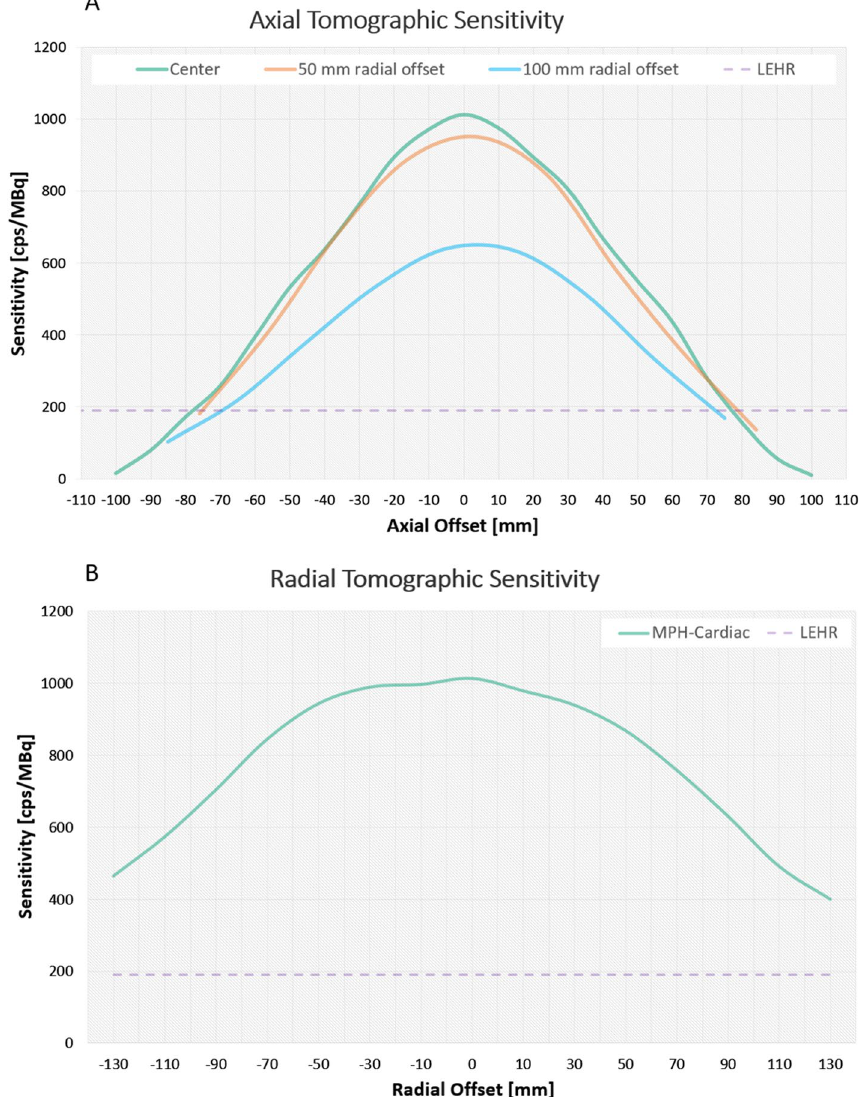
Fig. 2 Axial ( A ) and Radial ( B ) tomographic sensitivity profiles of the MPH‑Cardiac collimator system. The axial sensitivity profile was measured at 50 mm and 100 mm radial offsets. The reference line of the LEHR tomographic sensitivity is displayed as a dashed purple